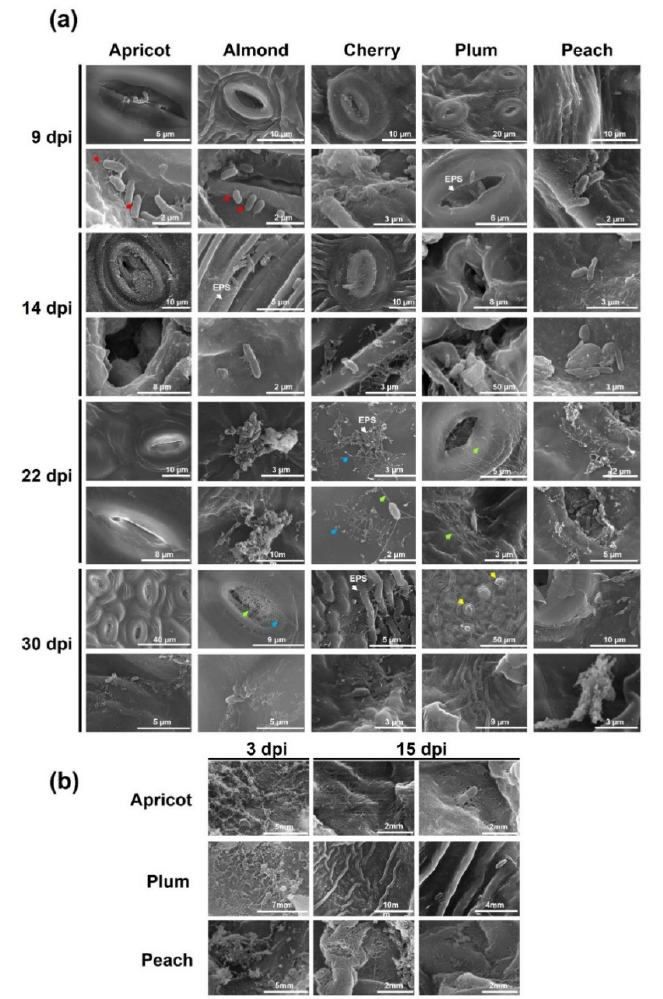
Figure 7. SEM analysis of colonization of CITA 33 strain on detached leaves of apricot, almond, cherry, plum and peach tree ( a ) and on detached fruit of apricot, plum and peach ( b ) at different days of bacterial post-inoculation (dpi).